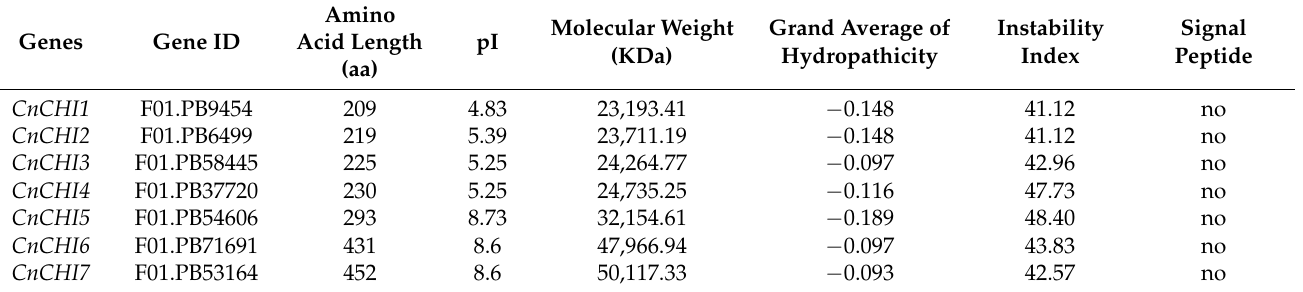
Table 1. Characteristics of CnCHI protein